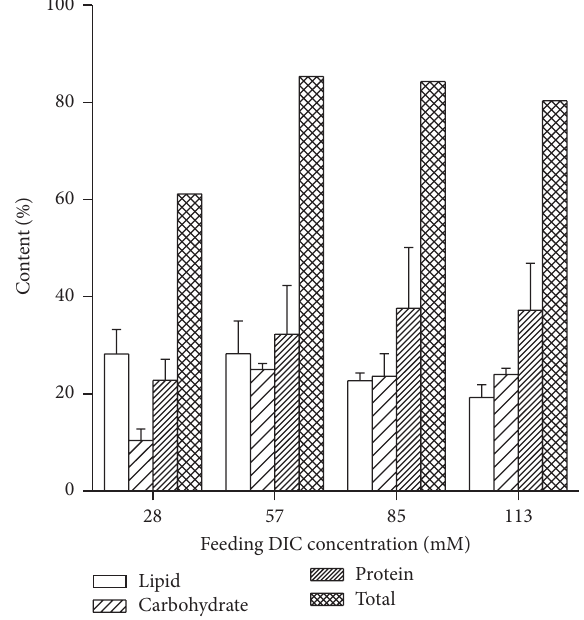
Figure 2: Cellular composition under various feeding DIC concen- trations in a continuous